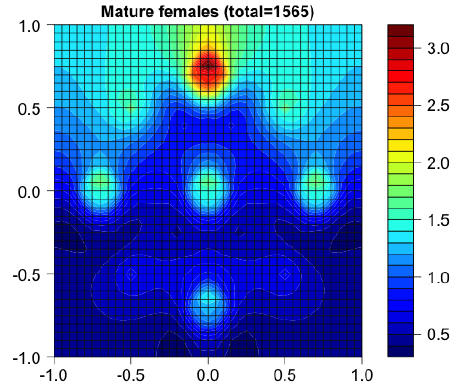
Mature Females distribution with North wind, and weekly releases of 1000 sterile males, near the South breading sites, from the 20th simulation